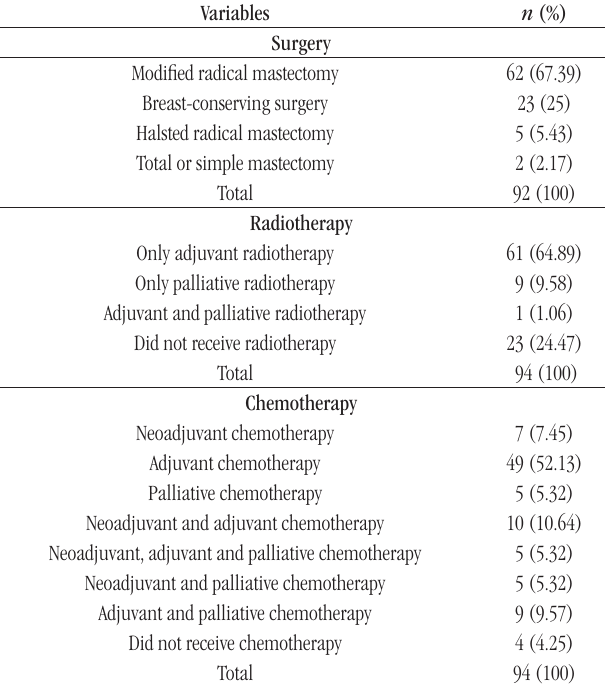
taBLE 3 − Treatment of triple-negative breast